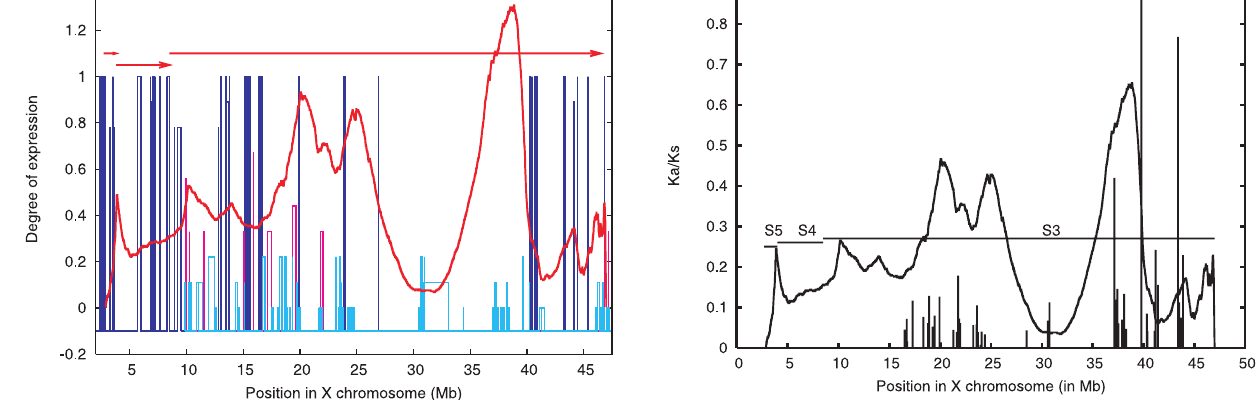
Figure 4. JS divergence values of unmasked XAR region (excluding PAR1). These divergence values were obtained using 2nd order Markov segmentation. XAR is comprised of three evolution- ary strata (shown by the horizontal arrows). The additional structures that give rise to the different peaks are discussed in the text. The coloured bars represent normalized expression levels (number of clones showing expression divided by number of clones examined) of XAR genes examined in [6]. Blue boxes indicate transcriptionally active genes with expression level ranging between 0.75–1, while cyan boxes indicate inactivated genes with expression level , 0.25. Expression levels of few genes (pink boxes) were intermediate of the two ranges and were considered ambiguous. The width of boxes represents the physical location of the gene.